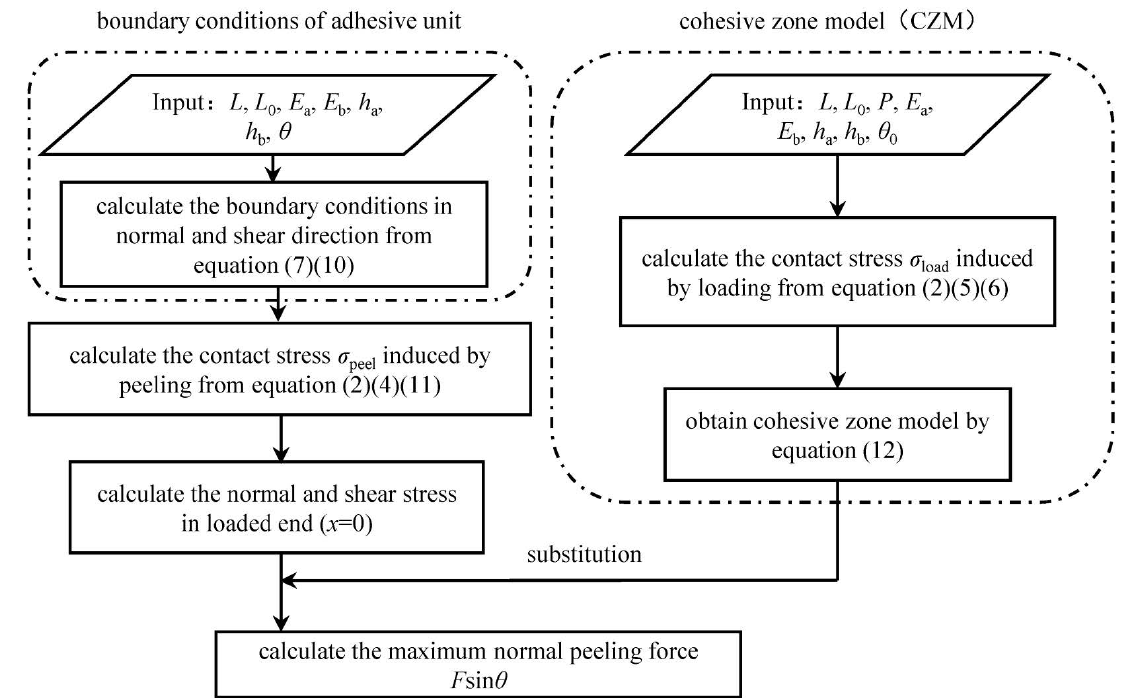
Figure 3. Mechanical analysis flow of rigid-flexible coupling adhesive unit during the compression and peeling